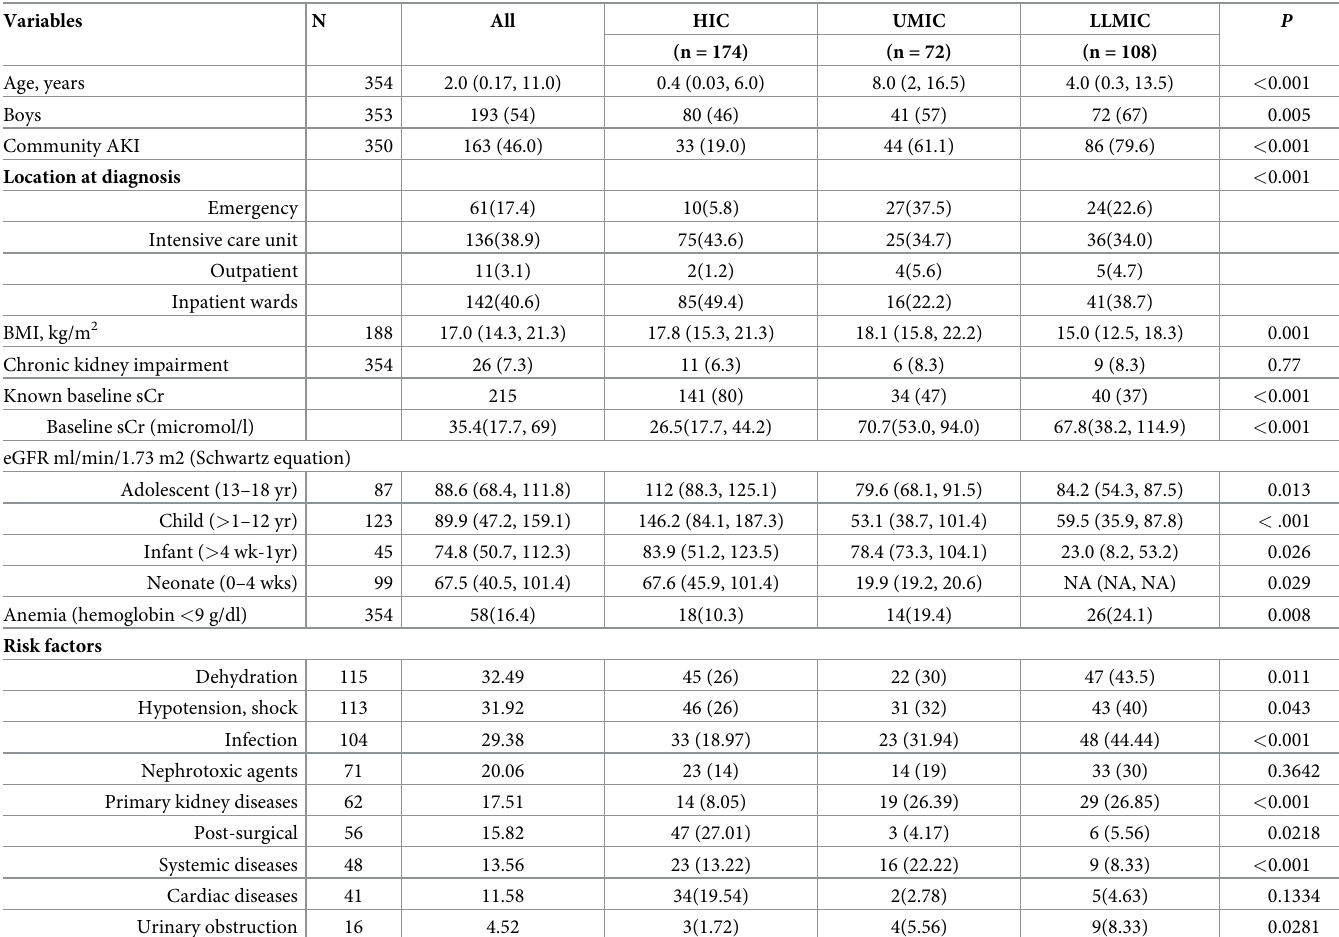
Table 1. Comorbidities, risk factors and location of AKI diagnosis in GNI country